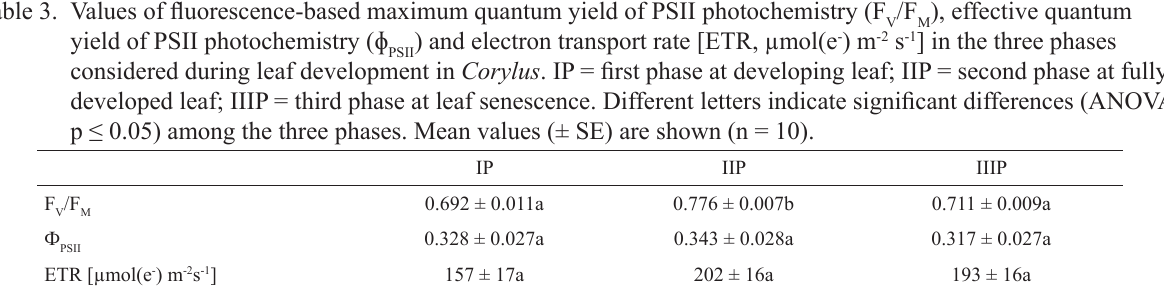
/F ), effective quantum V M